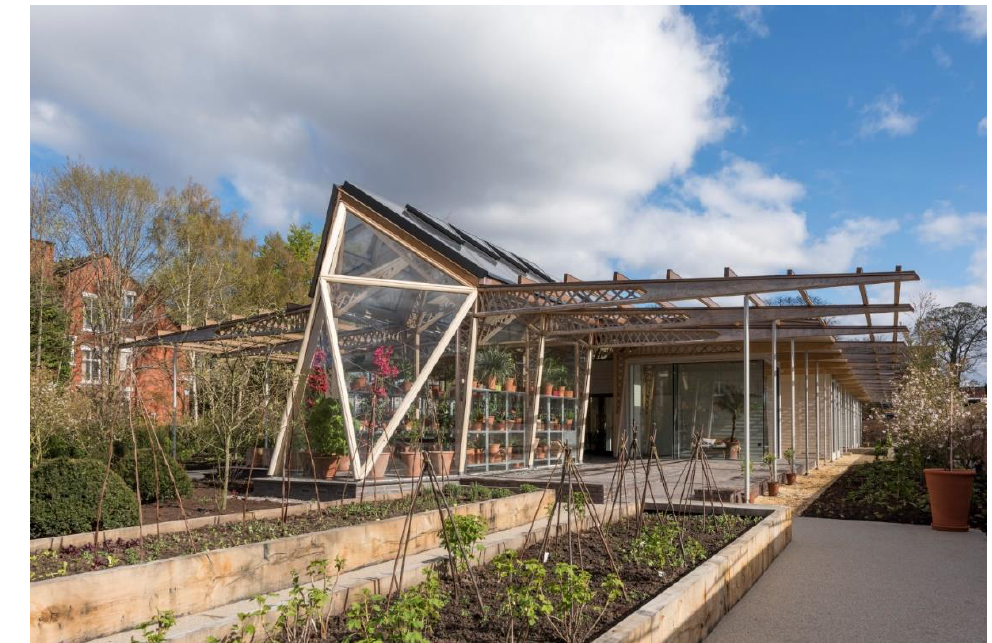
Figure 6. Maggie ’s Cancer Care Centre in Manchester, England. Figure 6. Maggie’s Cancer Care Centre in Manchester,